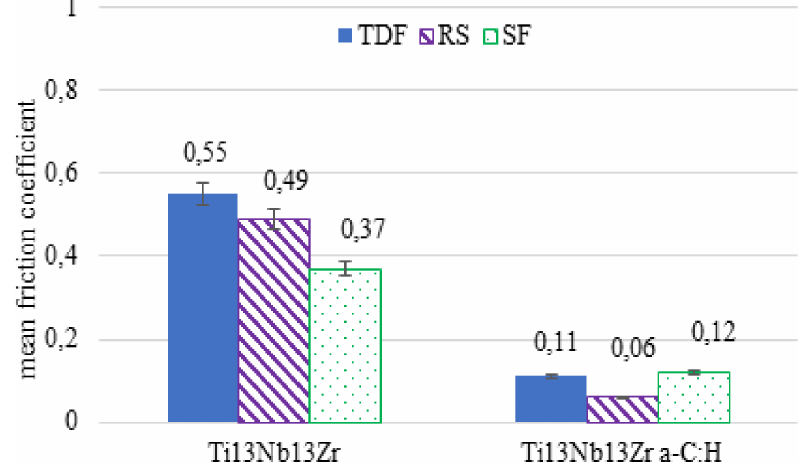
Figure 7: Mean coeflcient of friction during: technical dry friction (TDF), Ringer solution (RS) and synovial fluid